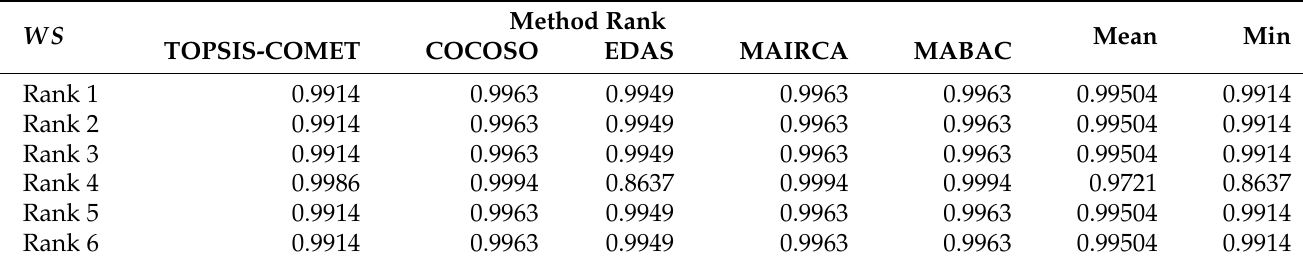
Table 18. Values of similarity coefficient WS for candidate compromise rankings with consideration of the whole dataset.